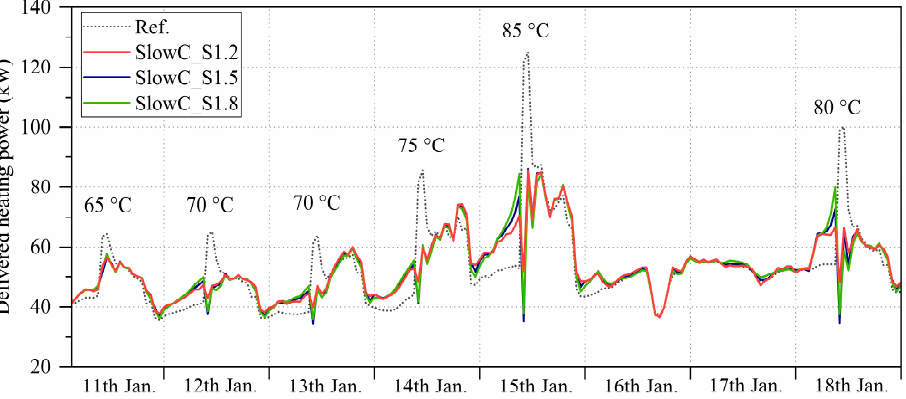
Figure 10. Delivered heating power with different sensor positions and maximum charging water temperature setpoints ( T set,max ) of a period in January.